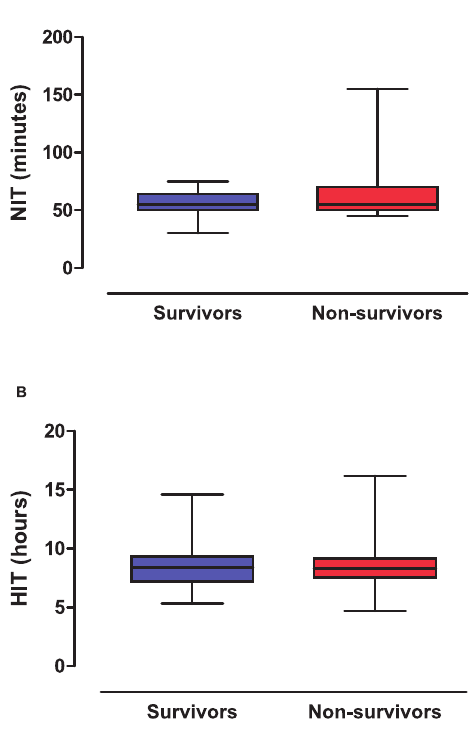
FIGURE 4 - Normothermic (panel A) and hypothermic (panel B) time for the patients of the survivor and non-survivor groups. The serum aminotransferase profile, ALT (panel A) and AST (panel B), determined preoperatively and for seven